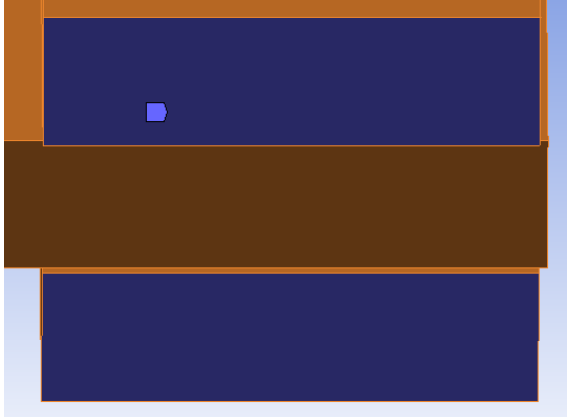
Figure 12. Boundary conditions of the numerical models.